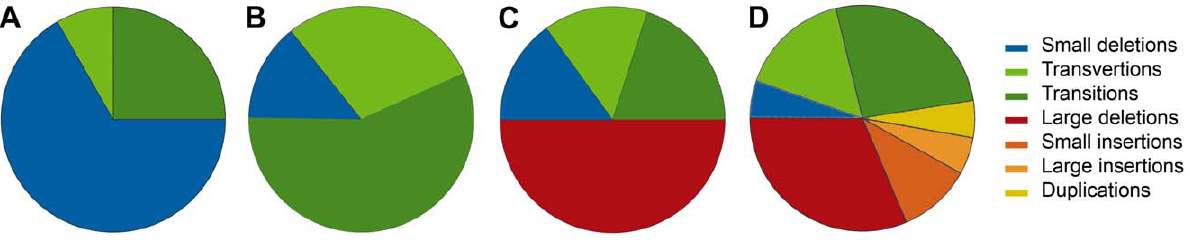
Figure 1. Mutational spectra of mucA , lasR , mexZ and MRS genes observed in P.aeruginosa isolates obtained from Argentinean CF patients. Pie charts indicate the observed percentage for each kind of mutation respect to the total number of mutations occurring in (A) mucA , (B) lasR , (C) mexZ and (D) MRS genes. The analyses on MRS genes include mutations observed in mutS and mutL.